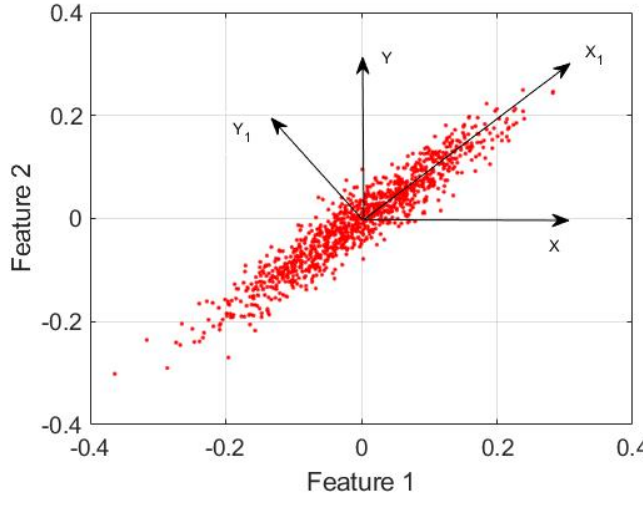
Figure 14. Example of PCA in R 2